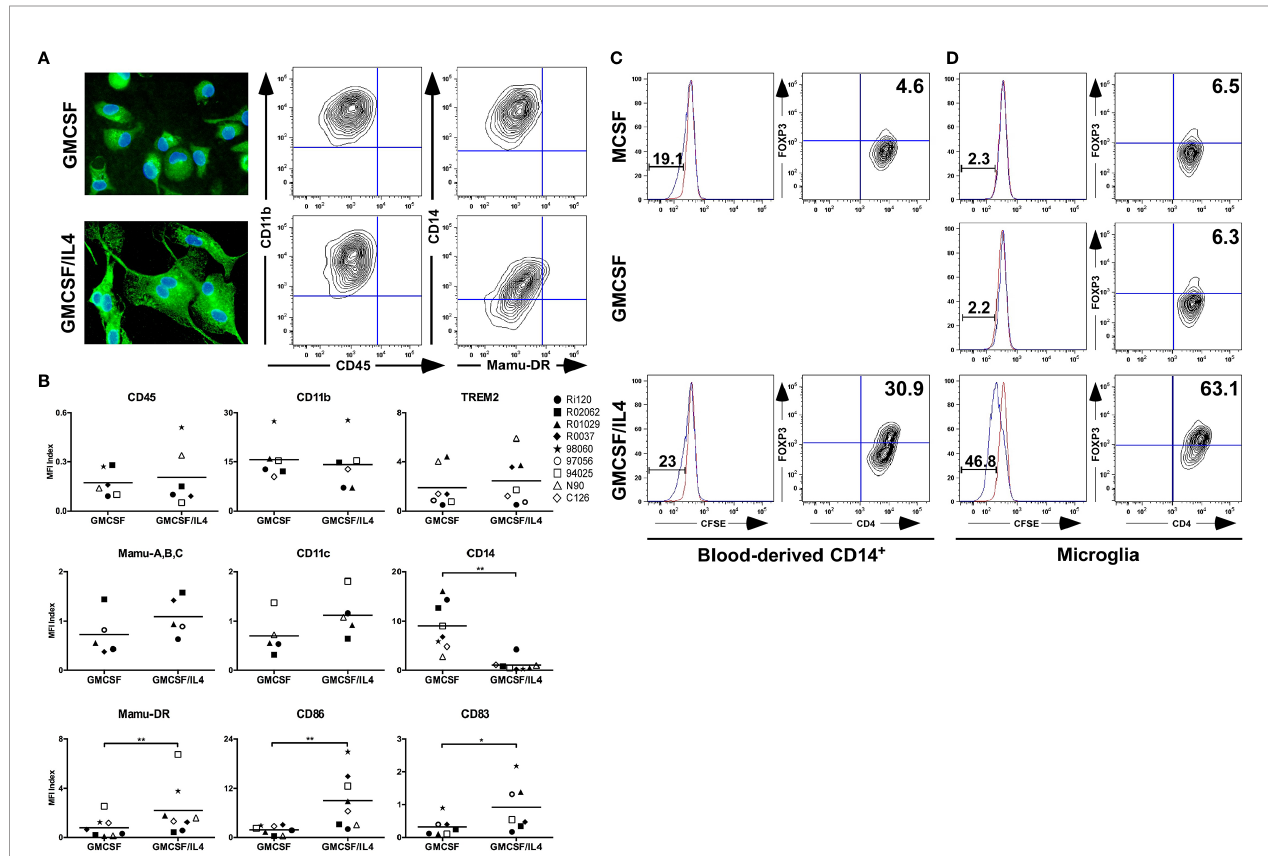
FIGURE 1 | Morphological, phenotypical and functional characterization of primary microglia exposed to IL-4. (A) Morphology of primary microglia exposed to GMCSF or GMCSF/IL-4 for 7 days (left panels), as visualized by TREM-2 expression (green). Cell nuclei (blue) were visualized using 4 ’ , 6-diamidino-2-phenylindole (DAPI). Original magni fi cations x20. Flow cytometric analysis of cell surface expression levels of CD11b, CD45, CD14 and Mamu-DR (right panels). A representative example of at least three different donors is shown. (B) Analysis of expression levels of cell surface markers on microglia exposed to GMCSF or GMCSF/IL-4. Levels are expressed as MFI index [(MFI protein of interest – MFI isotype control )/MFI isotype control ]. Different symbols represent different donors and horizontal lines indicate means. *p < 0.05 **p < 0.01 paired t-test. MFI, Mean fl uorescent intensity. Capacity of different antigen presenting cell populations (APC) to induce T cell proliferation in mixed lymphocyte reaction assays. Blood-derived CD14+ cells (C) or primary microglia (D) of the same donors were used as APC. CFSE dilution was measured in CD4+ T cells (left panels, red lines represent CFSE stainings in CD4+ T cells without APC) and Foxp3 expression levels were analyzed (right panels, numbers are % Foxp3+ CD4+ T cells). A representative example of three different donors is